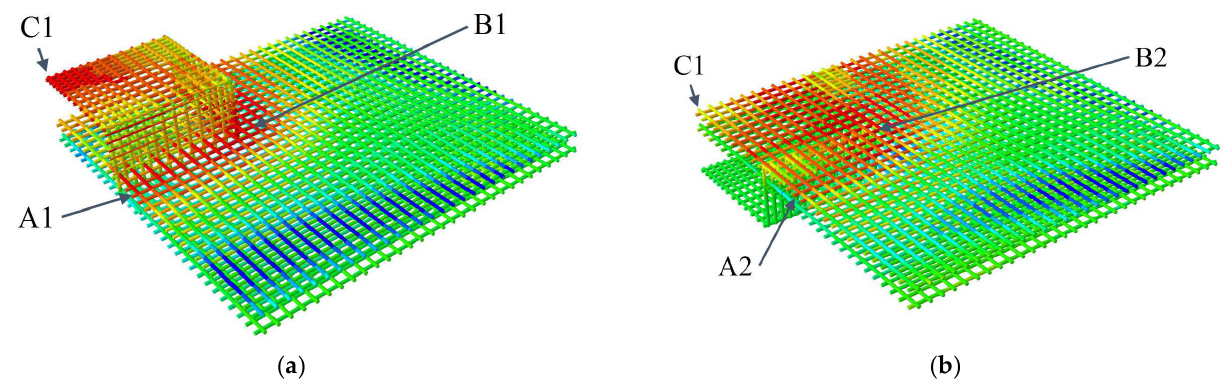
Figure 12. Selected positions of reinforcements: ( a ) ZM01 and ZM03; and ( b ) ZM02 and ZM04.